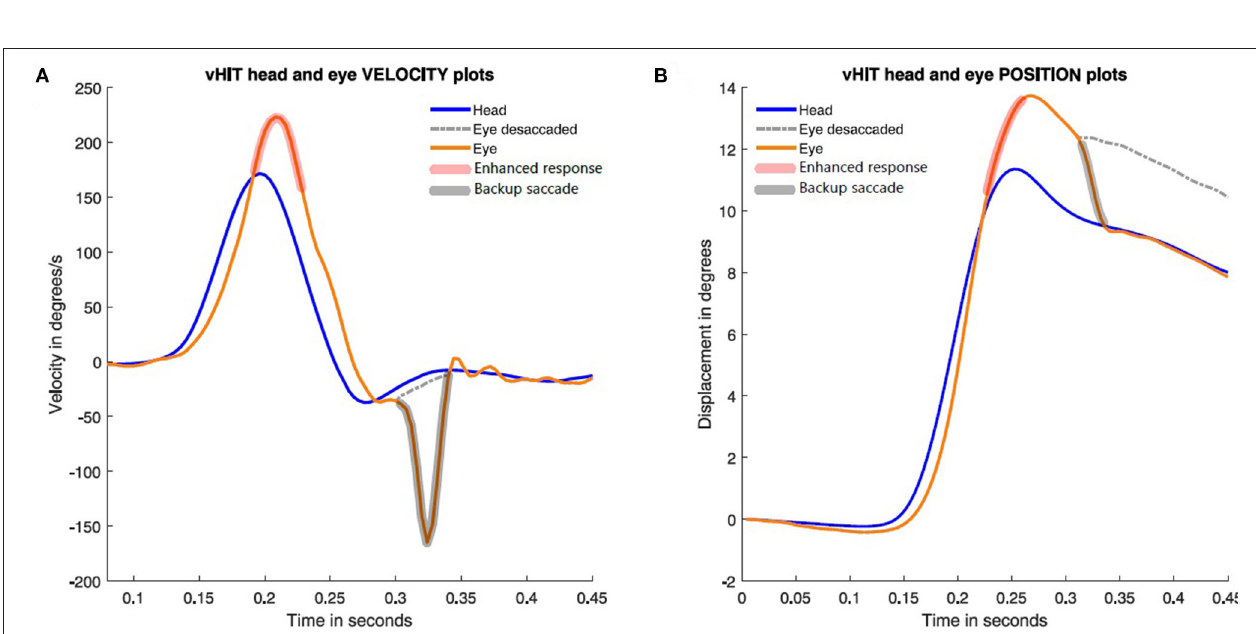
FIGURE 3 | Time series of head and eye velocity during the visual vestibular-ocular (VVOR) interaction test at 1.84Hz. There is evidence of enhanced eye velocity for rightward head turns and backup saccades are present in each rightward head turn. Normal eye velocity responses occur for leftward head rotations. In this VVOR figure, negative velocity values are assigned to right direction movement velocity. The VOR gain for the right and left sides were 1.07 and 0.91, respectively.